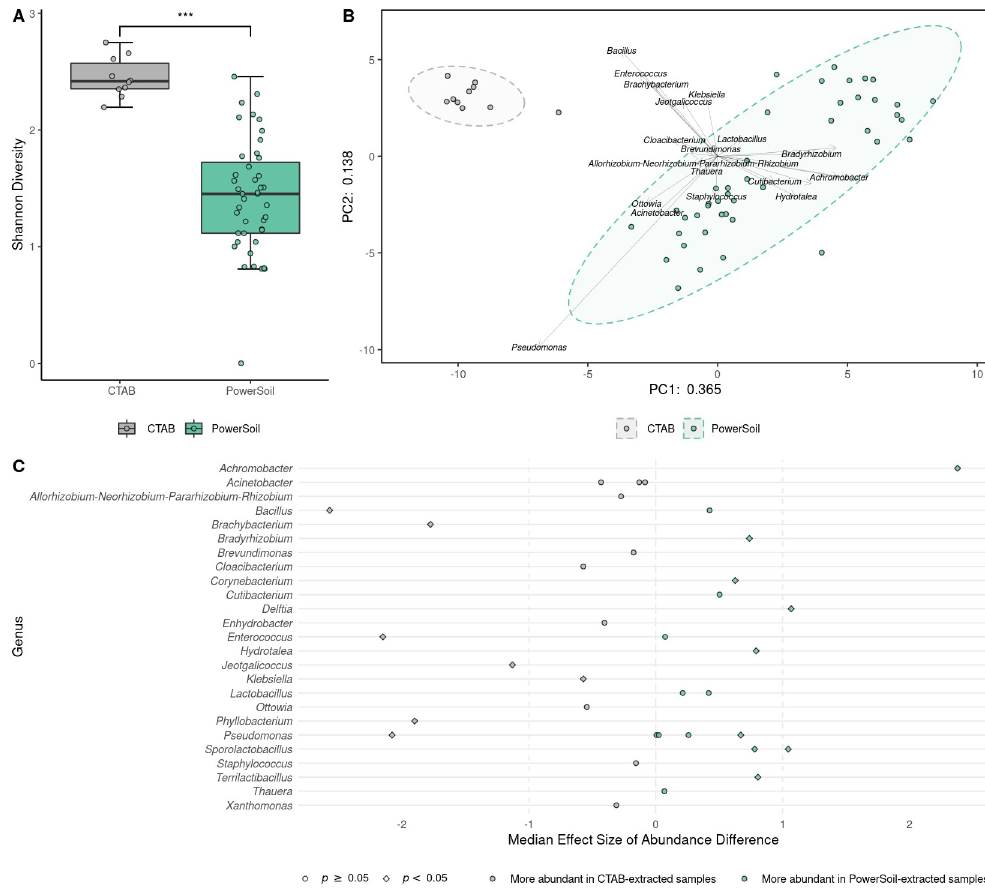
Fig 3. Samples differ significantly in Shannon diversity and abundance of ASVs depending on DNA extraction methodology. Samples were filtered normally and with SourceTracker and ASVs were filtered normally and with decontam. (A) Samples that had DNA extracted using the CTAB methodology ( n = 10) had significantly higher Shannon diversity than PowerSoil-extracted samples ( n = 43; Mann-Whitney U test; p = 9.9 × 10 − 9 ). Boxplots represent the median (line in box), first and third quartiles (edges of box), and most extreme values in the range median ± 1.5 × interquartile range (whiskers). (B) Principal component analysis of CLR-transformed Aitchison distances ( n = 10 CTAB-extracted samples and 43 PowerSoil-extracted samples). DNA extraction methodology was significantly associated with the ordination ( envfit from the vegan package; p = 0.001; r 2 = 0.5703). (C) Analysis of differences in ASV abundance between the PowerSoil ( n = 43) and CTAB ( n = 10) groups. Effect sizes and p -values (Mann-Whitney U test with Benjamini- Hochberg correction) were computed with